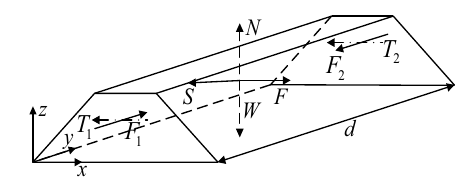
Fig. 4 Failure position of supporting coal pillar